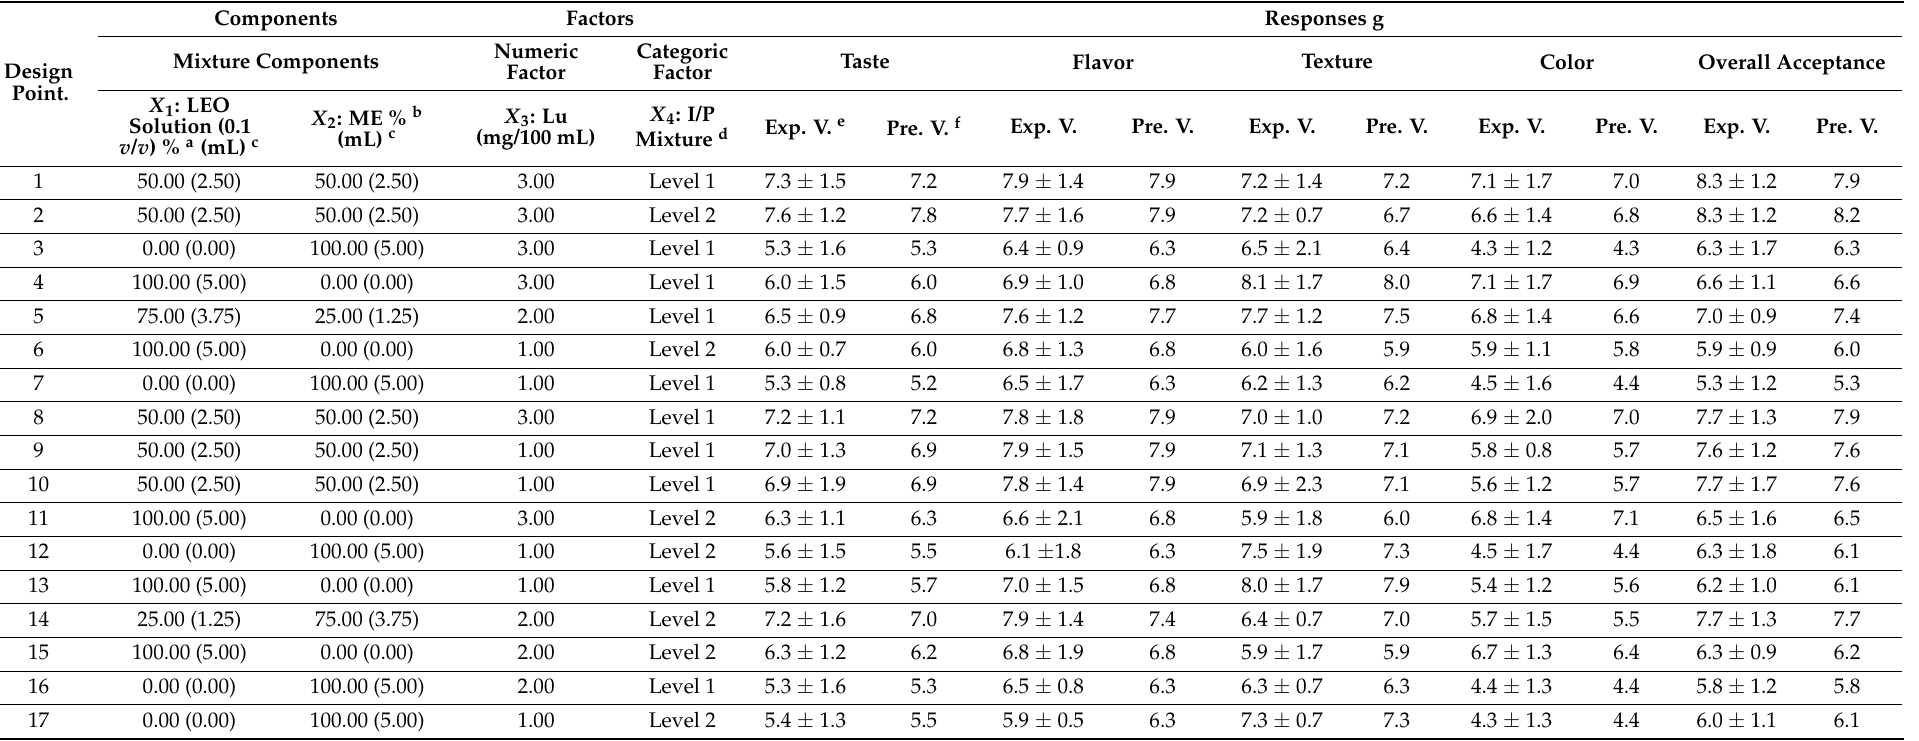
Table 1. Design of experiment for the optimization of the functional beverage formulation and corresponding sensory attributes, levels of independent variables, and values of the